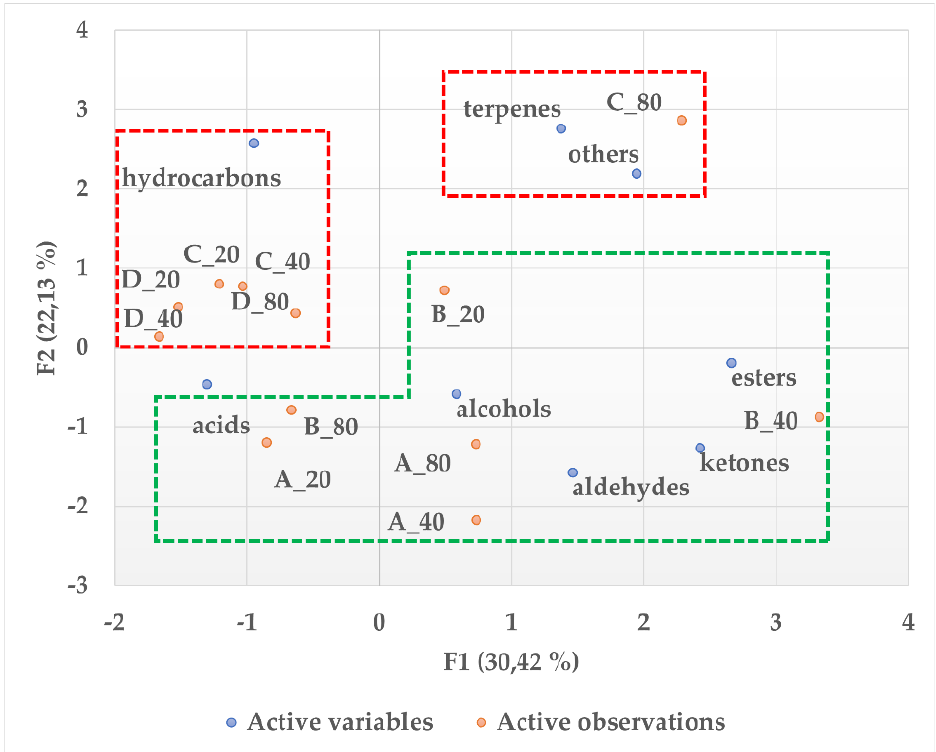
Figure 4. Principal component analysis (PCA) score plot for mistletoe macerates obtained after 28 days of mistletoe maceration (20 g/L, 40 g/L, and 80 g/L; ethanol – water solution A: 25%, B: 40%, C: 55%, and D: 70% v/v ethanol) at room temperature and in darkness, based on relative concentrations of individual groups of volatile substances in the macerates. Samples with lower ethanol content and characteristic volatiles are circled in green, samples with higher ethanol content and characteristic volatiles are circled in red.